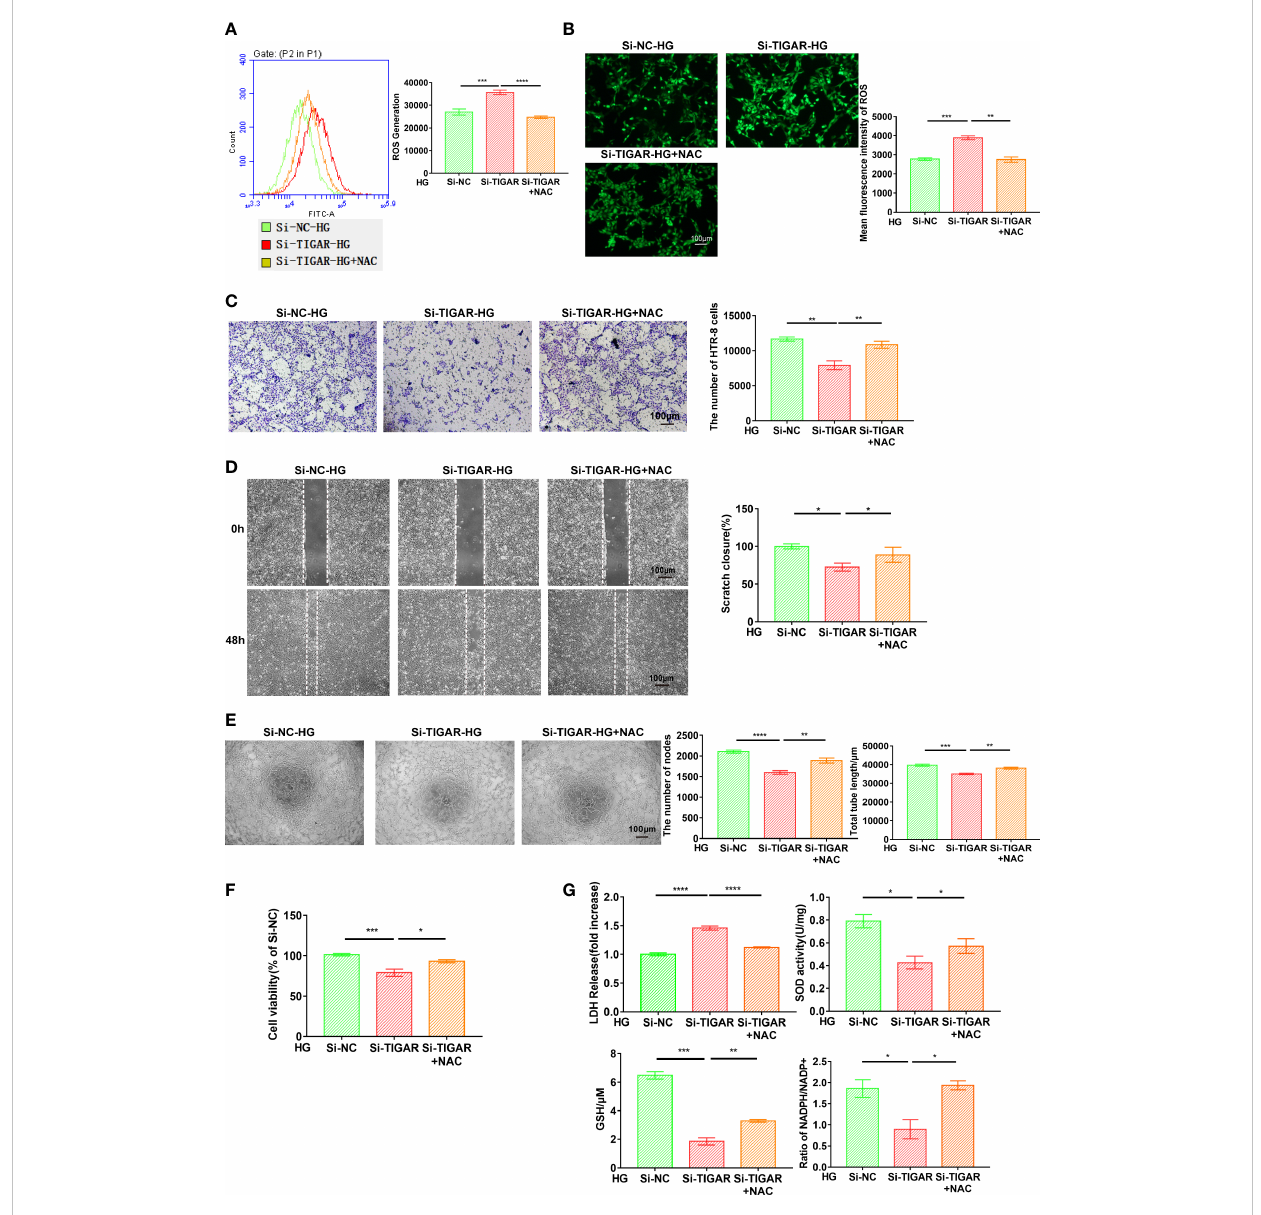
FIGURE 6 NAC attenuated oxidative stress and ameliorated cell function generated due to TIGAR de fi ciency. After successfully infected with TIGAR-siRNA or NC-siRNA, HTR-8 cells were pretreated with NAC for 1h and then cultured in HG condition prior to further experiments. Intracellular ROS levels were stained by DCFH-DA and then evaluated through fl ow cytometry (A) and monitored using a fl uorescence microscope (B) . Scale bar, 100 m m. Cell migration (C) , invasion (D) , tube formation (E) and cell viability (F) were assessed at the indicated times. (G) The evaluation of LDH release, SOD activity, GSH levels and NADPH/NADP + when cells pretreated with indicated concentration of NAC. Data of the triple experiments are presented as the means ± SEM. *p < 0.05, **p < 0.01, ***p < 0.001, ****p < 0.0001 versus the indicated